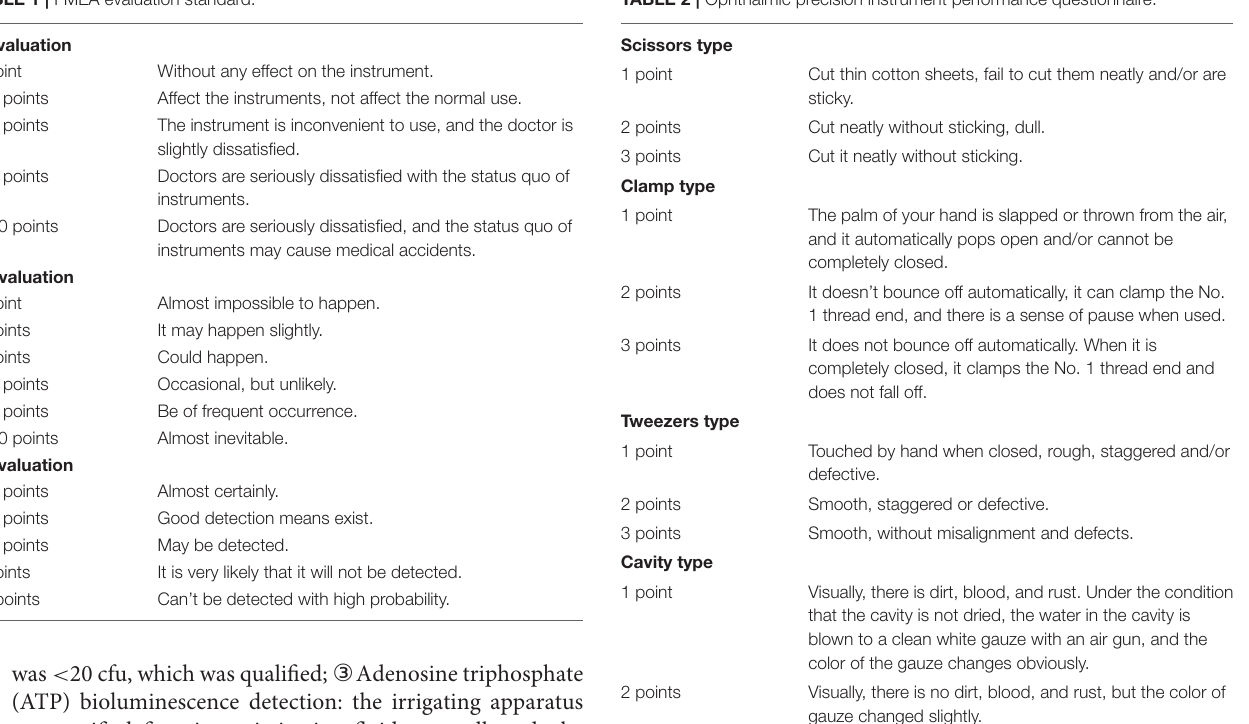
TABLE 2 | Ophthalmic precision instrument performance